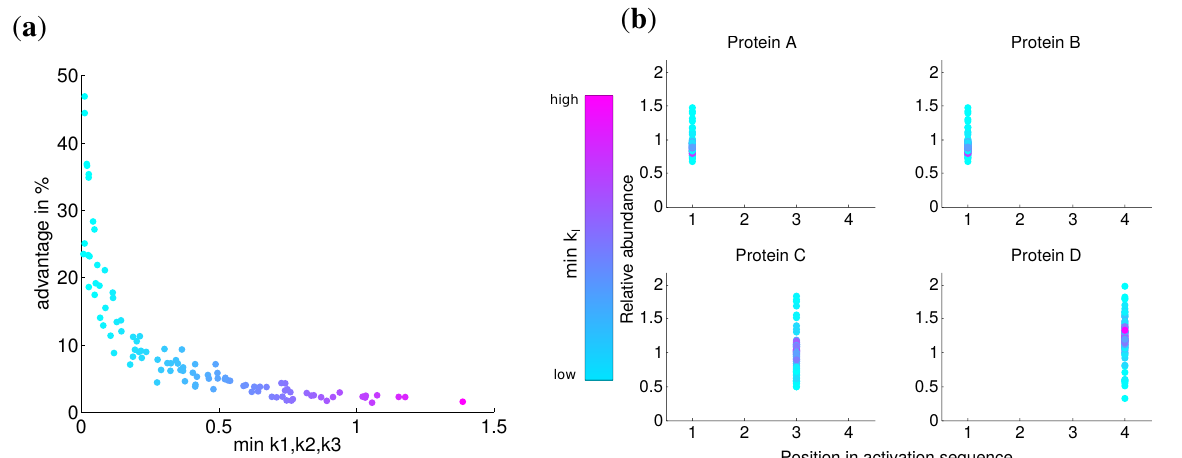
Figure 3. ( a ) Advantage of optimal solution compared to an assumed simultaneous synthesis of subunits in relation to the minimal kinetic parameter of each parameter set; ( b ) Position in activation sequence compared to the relative abundance for the same parameter sets as in ( a ). In both figures colors represent the minimal kinetic